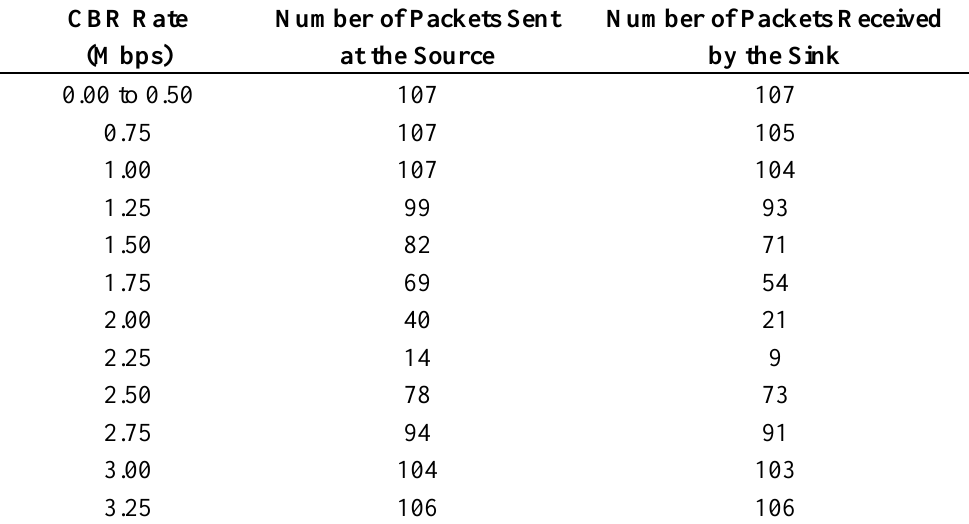
Table 3. Number of data packets successfully sent at the source and received by the sink versus the CBR